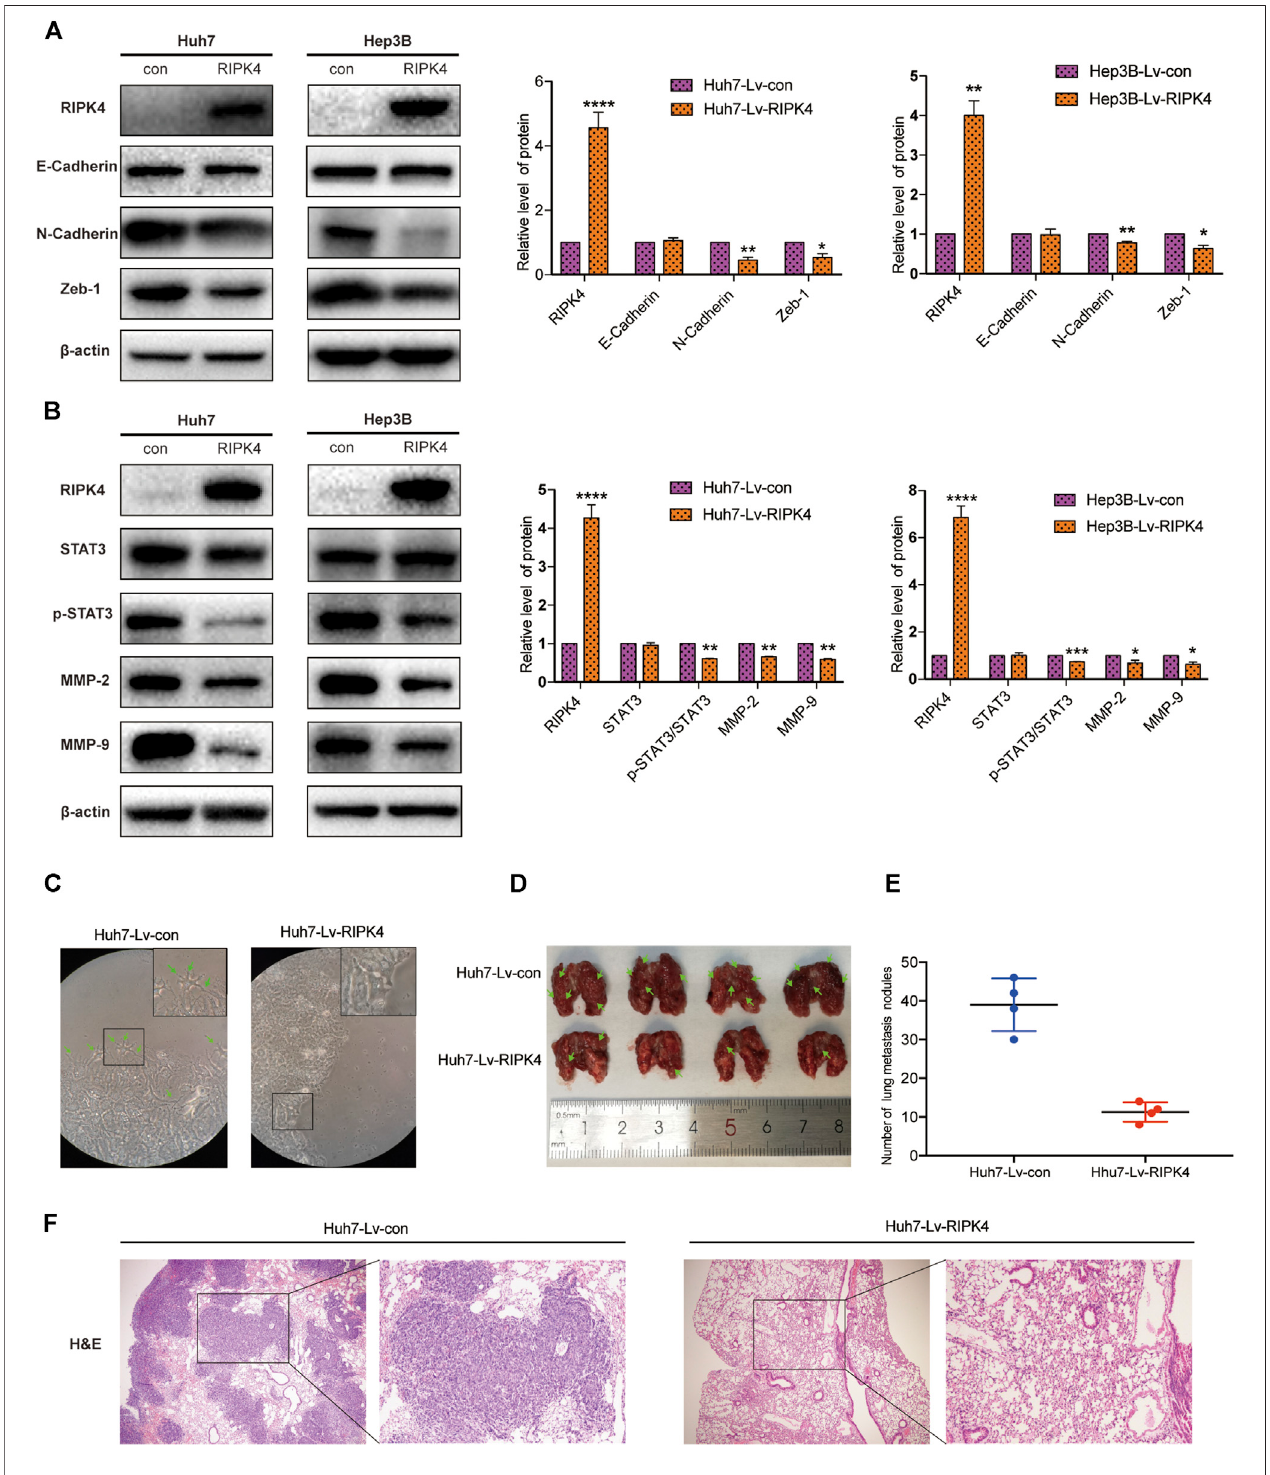
FIGURE 4 | RIPK4 inhibits EMT progression and STAT3 pathway activation in HCC. (A) Western blotting analysis of the expression levels of E-Cadherin, N-Cadherin, Vimentin, Zeb-1 protein in Huh7 and Hep3B cells infected with Lv-con and Lv-RIPK4 lentivirus, and ß -actin was used as a control. (B) Western blotting analysisofSTAT3,p-STAT3,MMP-2,MMP-9proteinexpressionlevelsinHuh7andHep3BcellsinfectedwithLv-conandLv-RIPK4lentivirus,and ß -actinwasusedasa control. (C) Representative images of huh7 morphology with Lv-con and Lv-RIPK4 lentivirus. (D,E) Representative images of lung metastases in mice and statistical analysis of the number of metastases. (F) Representative H&E staining pictures of mouse lung metastatic nodules. The data are expressed as mean ± SD. ** p < 0.01; *** p < 0.001.